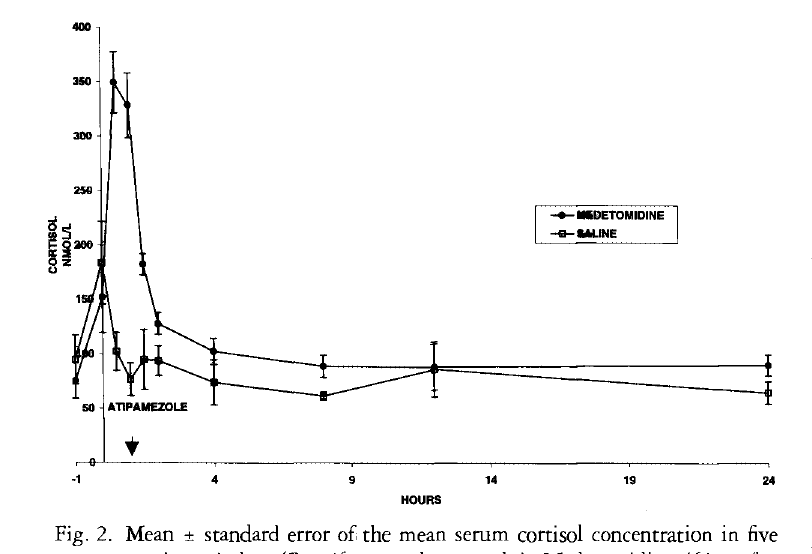
Fig. 2. Mean ± standard error of the mean serum Cortisol concentration in five caprive reindeer (Rangifer tarandus tarandus). Medetomidine (60 P-g/kg i.v.) was followed by atipamezole (300 (Xg/kg i.v.) after 1 h (arrow). The experiments were conducted in January and repeated in July-Augusr.